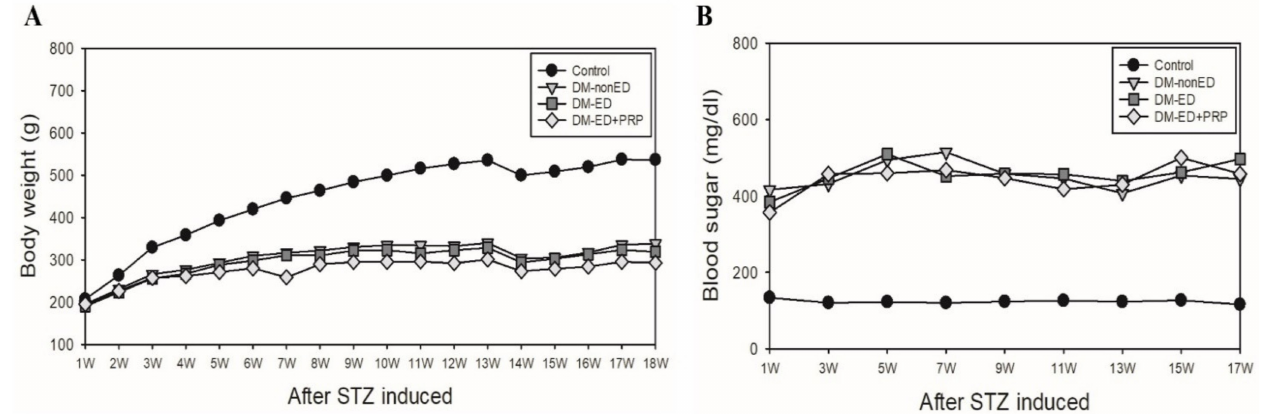
Figure 1. Graph showing the changes in body weight and blood glucose level of the normal control and experimental rats. ( A ) Graph showing the body weight changes of rats in each group and their respective control. ( B ) Graph showing the variations in the blood glucose levels of the rats in each group and their respective control. The body weight was recorded since the rats were six weeks old, and the streptozotocin (STZ) was also induced simultaneously, following blood sugar tested on the next week (7 weeks old). DM-non-ED, STZ-induced diabetes mellitus (DM) without erectile dysfunction (ED); DM-ED, STZ-induced DM with ED and treated with saline; DM-ED + PRP, STZ-induced DM with ED and treated with